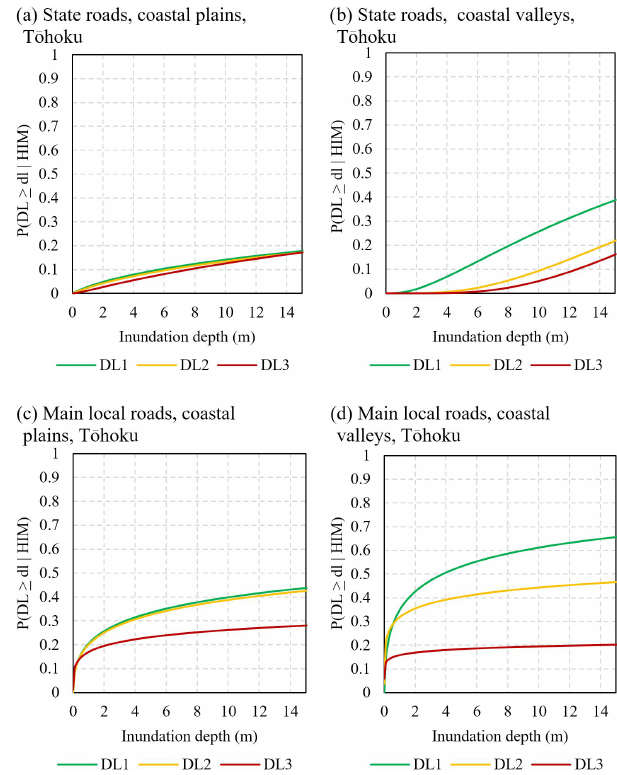
Figure 20. Fragility functions for road state roads on coastal plains (a) and coastal valleys (b) and for main local roads on coastal plains (c) and coastal valleys (d) for the 2011 T¯ohoku earthquake and tsunami,